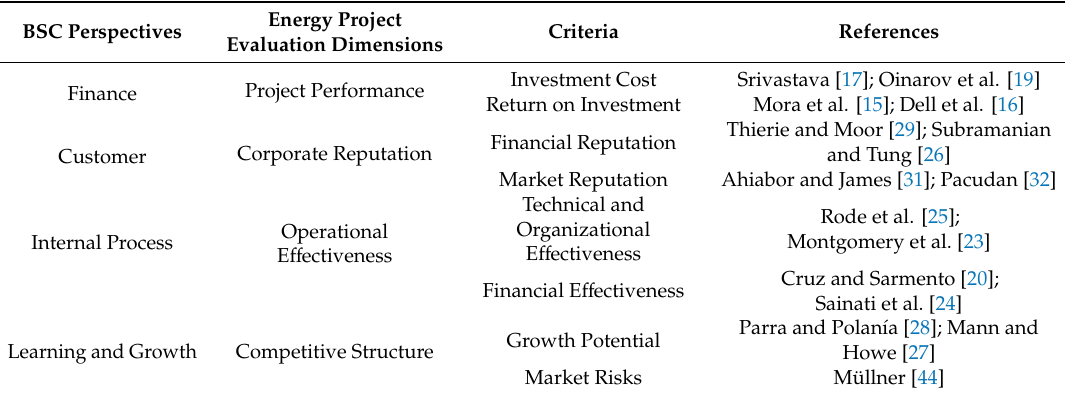
Table 1. The Details of Dimensions and